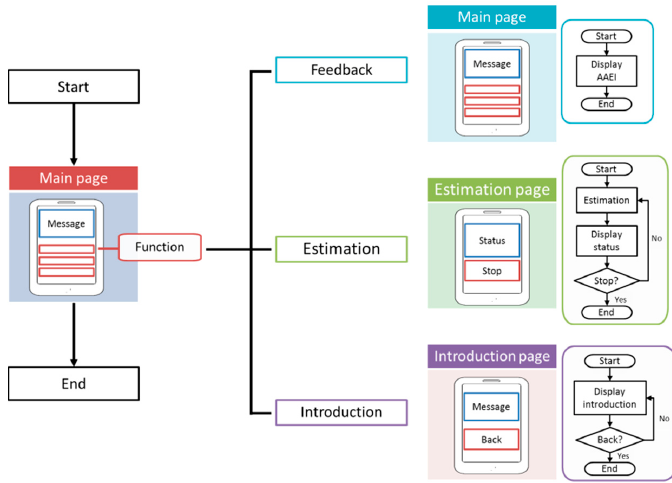
Figure 3. Exercise performance measurement system using Android for implementation.